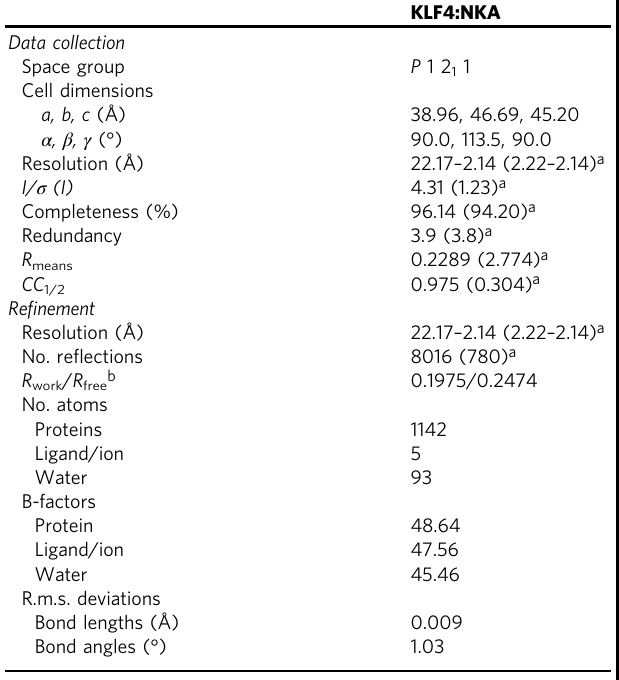
Table 1 Data and re fi nement